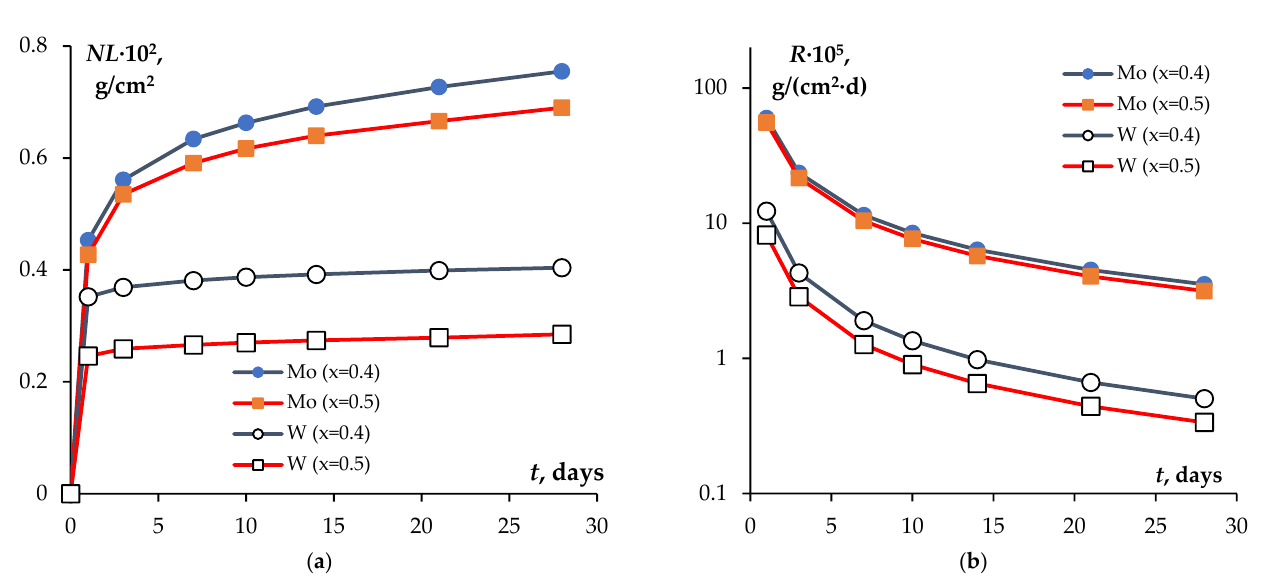
Figure 9. Time dependences of normalized weight loss NL ( a ) and normalized leaching rates for certain components per unit surface area R ( b ) in the Na 1−x Zr 2 (PO 4 ) 3−x (ХO 4 ) x ceramics.